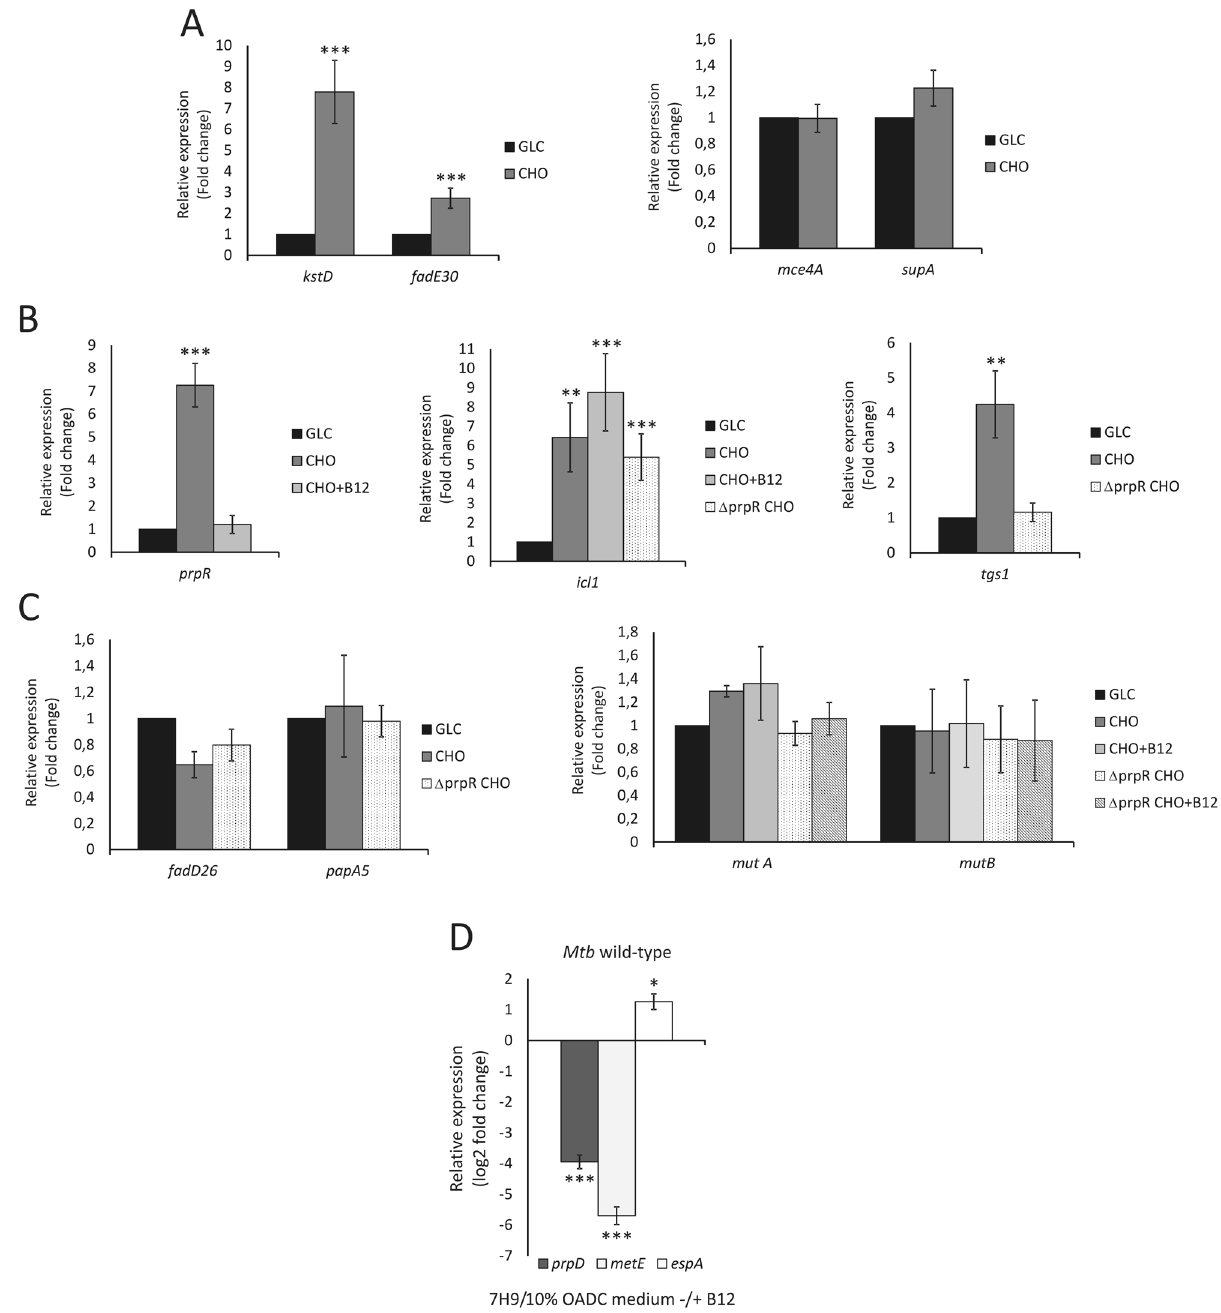
Figure 5. qRT-PCR validation of the expression of the selected genes in various growth conditions. Selected genes represent the main metabolic pathways discussed in this study. ( A ) Differential expression of the representative cholesterol breakdown ( kstD , fadE30 ) and import ( mce4 , supA ) genes. ( B ) Differential expression of the representative genes of Mtb central metabolism ( prpR , icl1 ) and TAG synthesis gene tgs-1 . ( C ) Differential expression of the representative genes of Mtb virulence lipid synthesis ( fadD26 , papA5 ) and the methylmalonyl pathway (MMP) ( mutA , mutB ). ( D ) Change in expression of PrpR operon genes (represented here by prpD ) in response to vitamin B 12 in Mtb wild-type growing in standard 7H9/10% OADC medium. The expression of metE was used as an example of confirmed B 12 -dependent regulation of gene expression. qRT-PCR analysis of espA (representative of the EspR regulon) expression in medium with or without B 12 supplementation confirms the discussed influence of vit. B 12 on the expression of ESX-1 associated genes. GLC Mtb growing on glycerol, CHO Mtb growing on cholesterol, CHO+B12 Mtb growing on cholesterol and vitamin B 12 , ∆prpR CHO ∆ prpR mutant growing on cholesterol, ∆prpR CHO+B12 ∆ prpR mutant growing on cholesterol and vitamin B 12 . Statistical significance: one, two and three stars denote p values ≤0.05, ≤0.01 and ≤0.001, respectively (Student’s